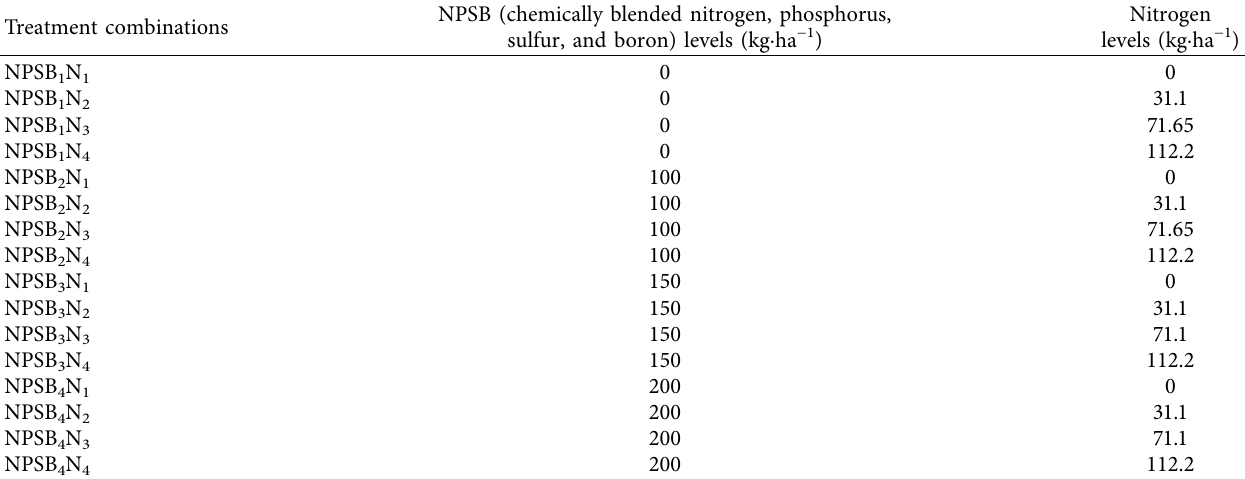
Table 1: Description of treatment combinations.